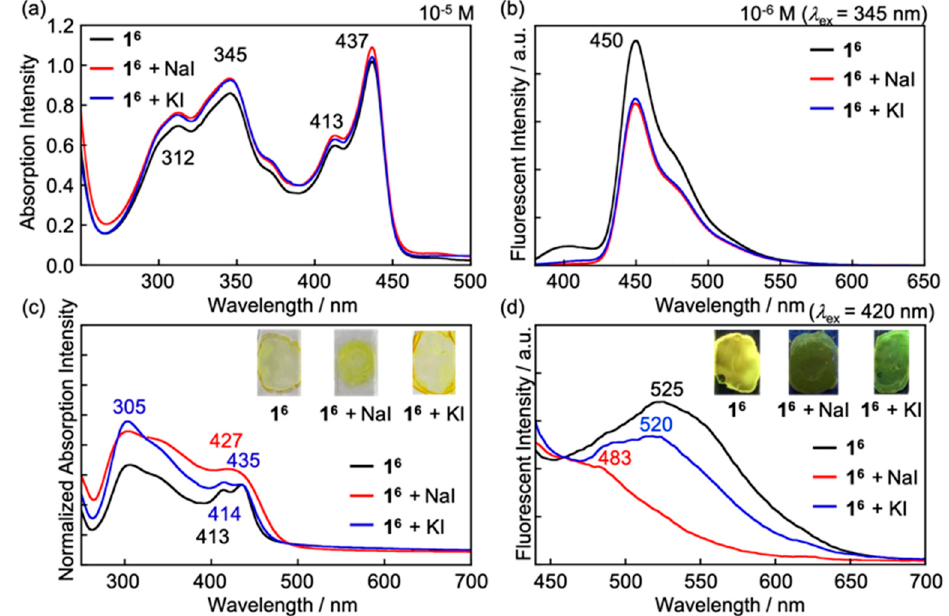
Figure 7. UV-vis absorption spectra and photographs in CHCl 3 solutions ( a ) and in solid states ( c ) and fluorescent spectra and photographs in CHCl 3 solutions ( b ) and in LC states ( d ) for complexes 1 6 with BSA.